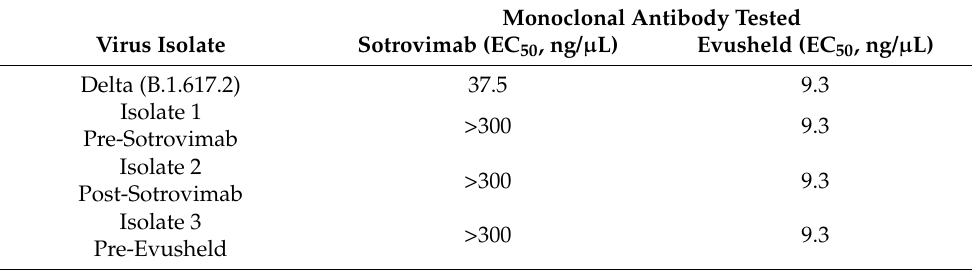
Table 3. Half-maximal effective concentration (EC 50 ) of tested monoclonal antibodies (sotrovimab, Evusheld) against the three different patient isolates (pre- and post-sotrovimab, pre-Evusheld) and the Delta strain (B.1.617.2). Sotrovimab concentration range: 300–2.1 ng/ µ L; Evusheld: 600 (300 +